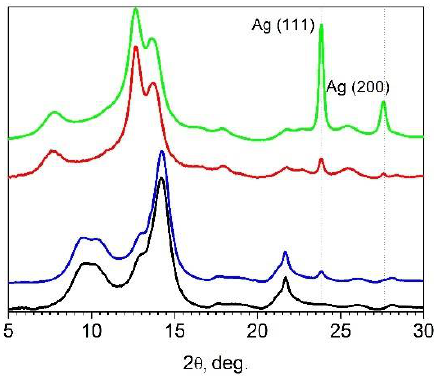
Figure 8. X-ray diffraction patterns ( λ = 0.9752 Å) for cellulose samples: MCC (black), AC (red), Ag-MCC (blue) and Ag-AC (green).